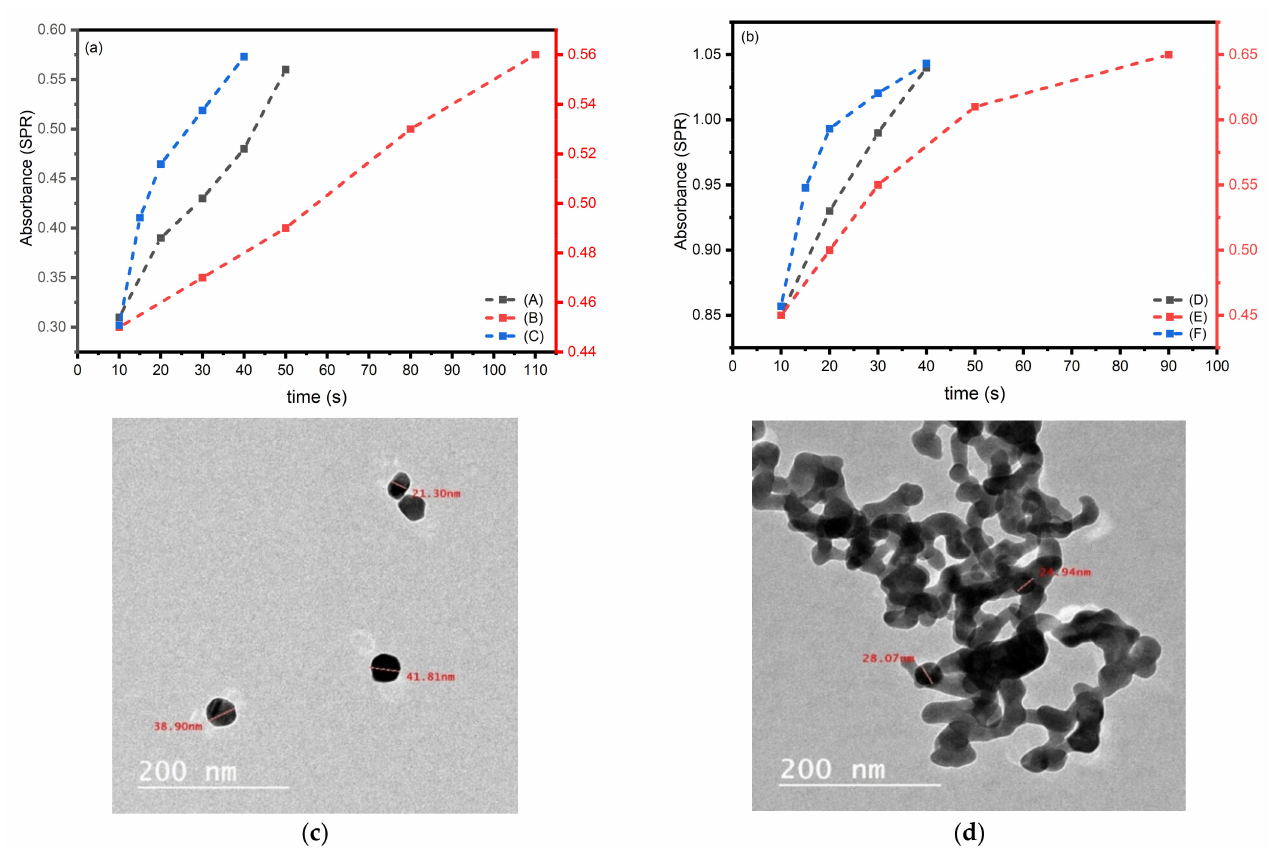
Figure 7. Plots of comparison between the PIS system based on R3 0.2 wt%/TEA 0.2 wt%/AgNO 3 2 wt% (A), on R3 0.2 wt%/Iod 1 wt%/AgNO 3 2 wt% (B) and the PIS system based on R3 0.2 wt%/TEA/Iod 1 wt%/AgNO 3 2 wt% solution (C) ( a ), and the PIS system based on R4 0.2 wt%/TEA 0.2 wt%/AgNO 3 2 wt% (D), on R4 0.2 wt%/Iod 1 wt%/AgNO 3 2 wt%(E) and the PIS system based on R4 0.2 wt%/0.2 wt%TEA 0.2 wt%/Iod 1 wt%/AgNO 3 2 wt% solution (F) ( b